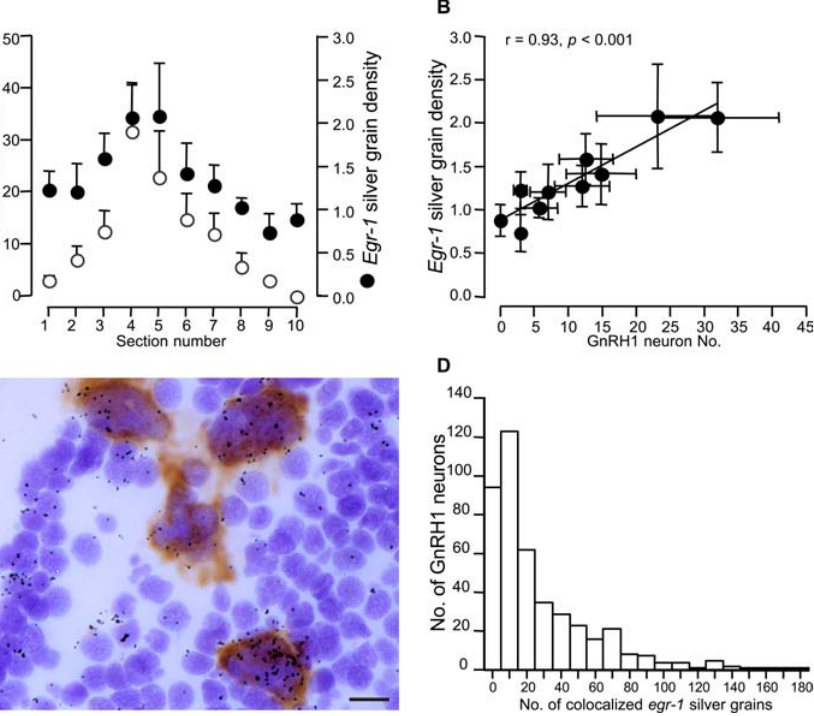
Figure 5. Relationship between egr-1 and GnRH1 in the aPPn (A) Mean þ SE GnRH1 neuron number (indicated by an open circle) and egr-1 silver grain density (indicated by a closed circle) by section number (rostral to caudal). (B) Covariation of mean 6 SE GnRH1 neuron number and egr-1 silver grain density within sections. (C) Photomicrograph of egr-1 (silver grains) and GnRH1 (brown precipitate) expressing neurons in the aPPn. Scale bar represents 10 l m. (D) Histogram showing the number of GnRH1 neurons with the corresponding range of co-localized egr-1 silver grains. DOI: 10.1371/journal.pbio.0030363.g005 PLoS Biology |